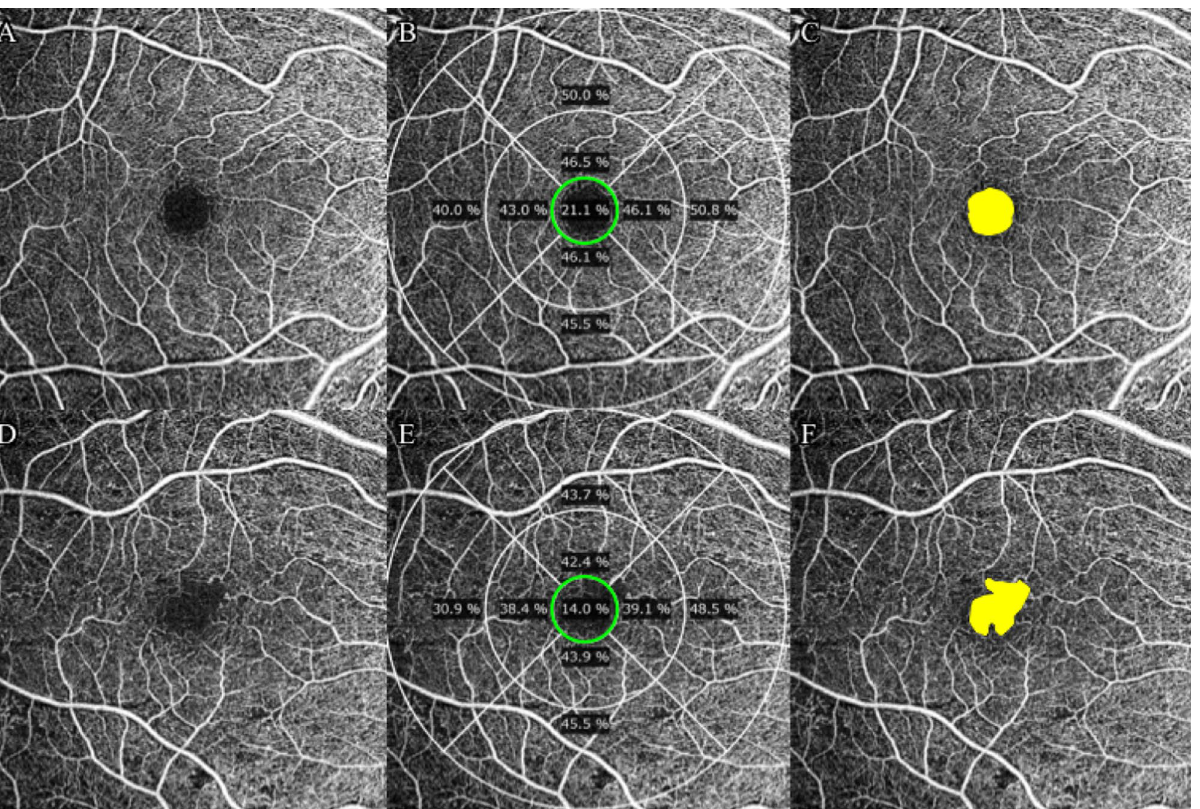
Figure 3. Superficial capillary plexus (SCP) en face images of optical coherence tomography angiography (OCTA). The Early Treatment Diabetic Retinopathy Study (ETDRS) 9 grid in 6 × 6 mm scan. ( A , D ) Shows SCP retinal vessels in control and nonproliferative diabetic retinopathy eyes. ( B , E ) Vessel density of SCP in central subfield (green ring) is calculated automatically by the software. ( C , F ) Foveal avascular zone (FAZ) area and circularity (yellow area) are automatically calculated by the software. In this study, AngioPlex OCT angiography (software version 11.0.0.20046, https ://www.zeiss .com/medit ec/int/home.html) was